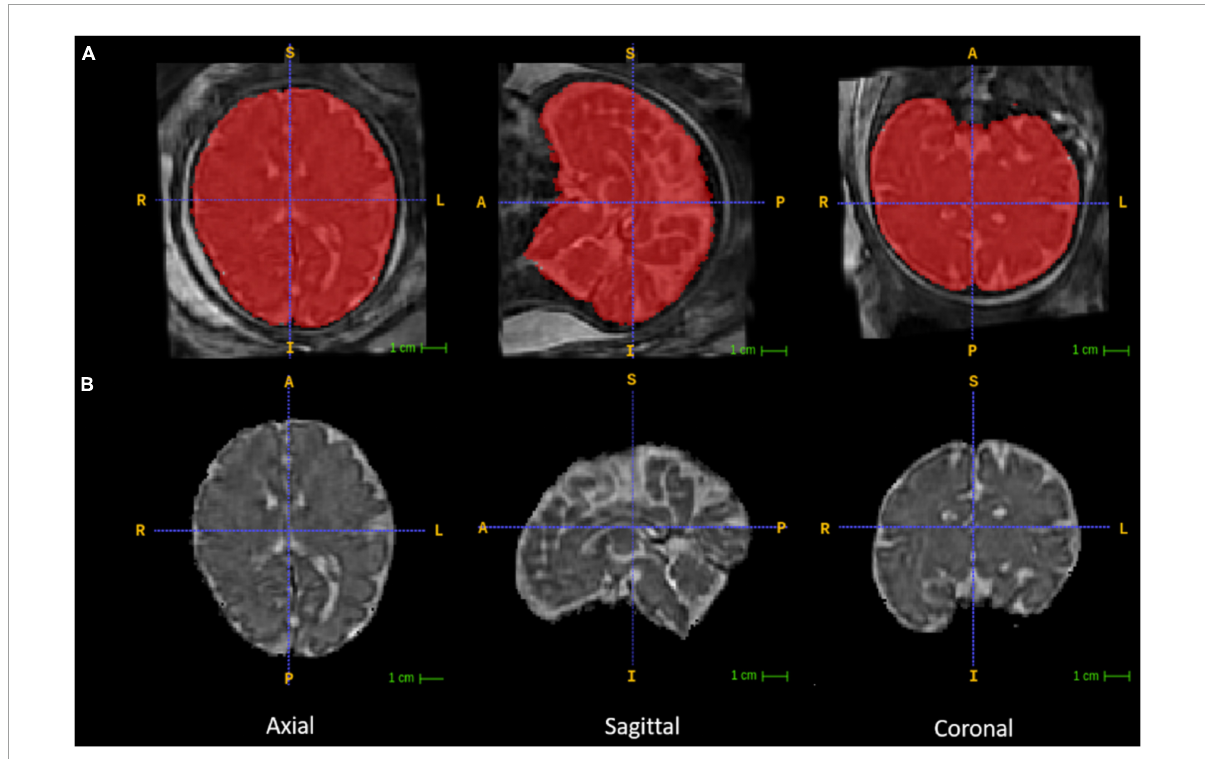
FIGURE2 Fetal brain segmentation. Row (A) includes the volumetrically reconstructed fetal brains in three planes. The red areas are the manually segmented fetal brain binary masks. Row (B) includes the orientation-corrected and skull-stripped (using the binary masks in red) fetal brain volumes in three planes.